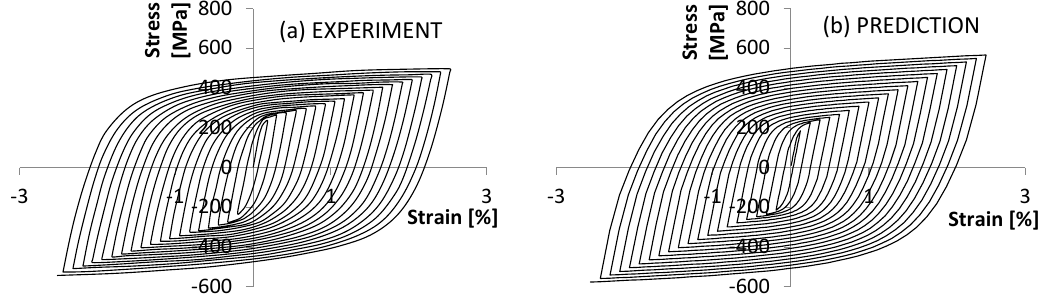
Figure 7. Prediction of the incremental test with the linearly-increasing amplitude of the axial stress: ( a ) experiment (experimental data were taken from [15]); ( b )